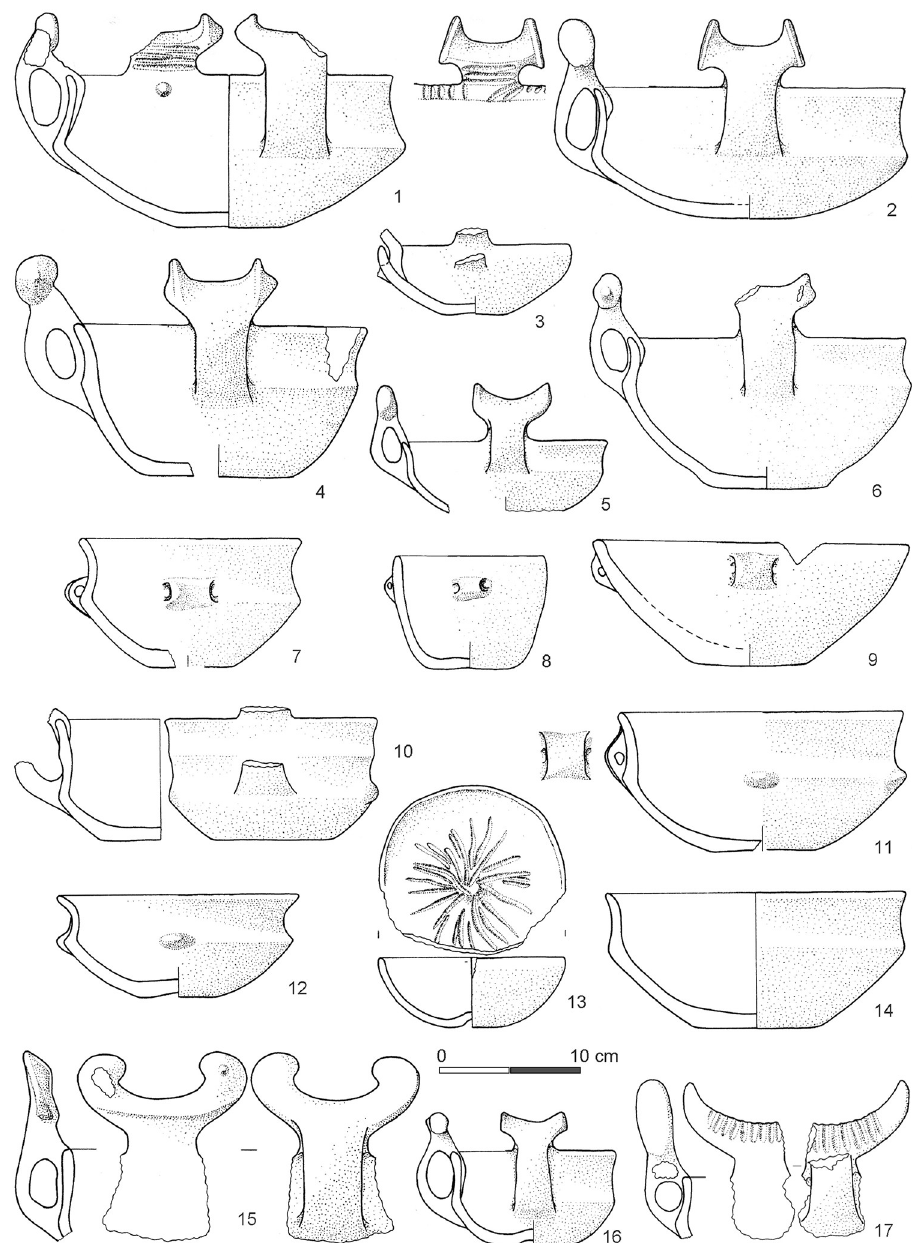
Fig 9. Selection of archaeological material from the upper tank dating to the BM3 phase (from [10]). Pots 1 and 2 are from SU 87a; pots 3 and 9 are from SUs 81, 81c, 81d-e; pots 10 and 14 are from SU 66base; pot 15 is from SU 5003 (this SU is associated to the 14 C age Poz-19307 in Table 4 below); pots 16 and 17 are from SU